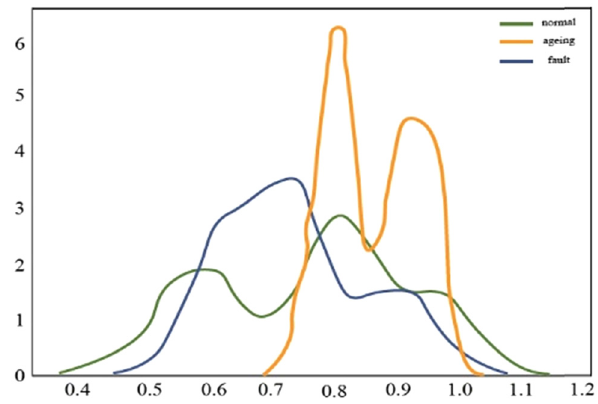
Figure 4: DET probability density curve.